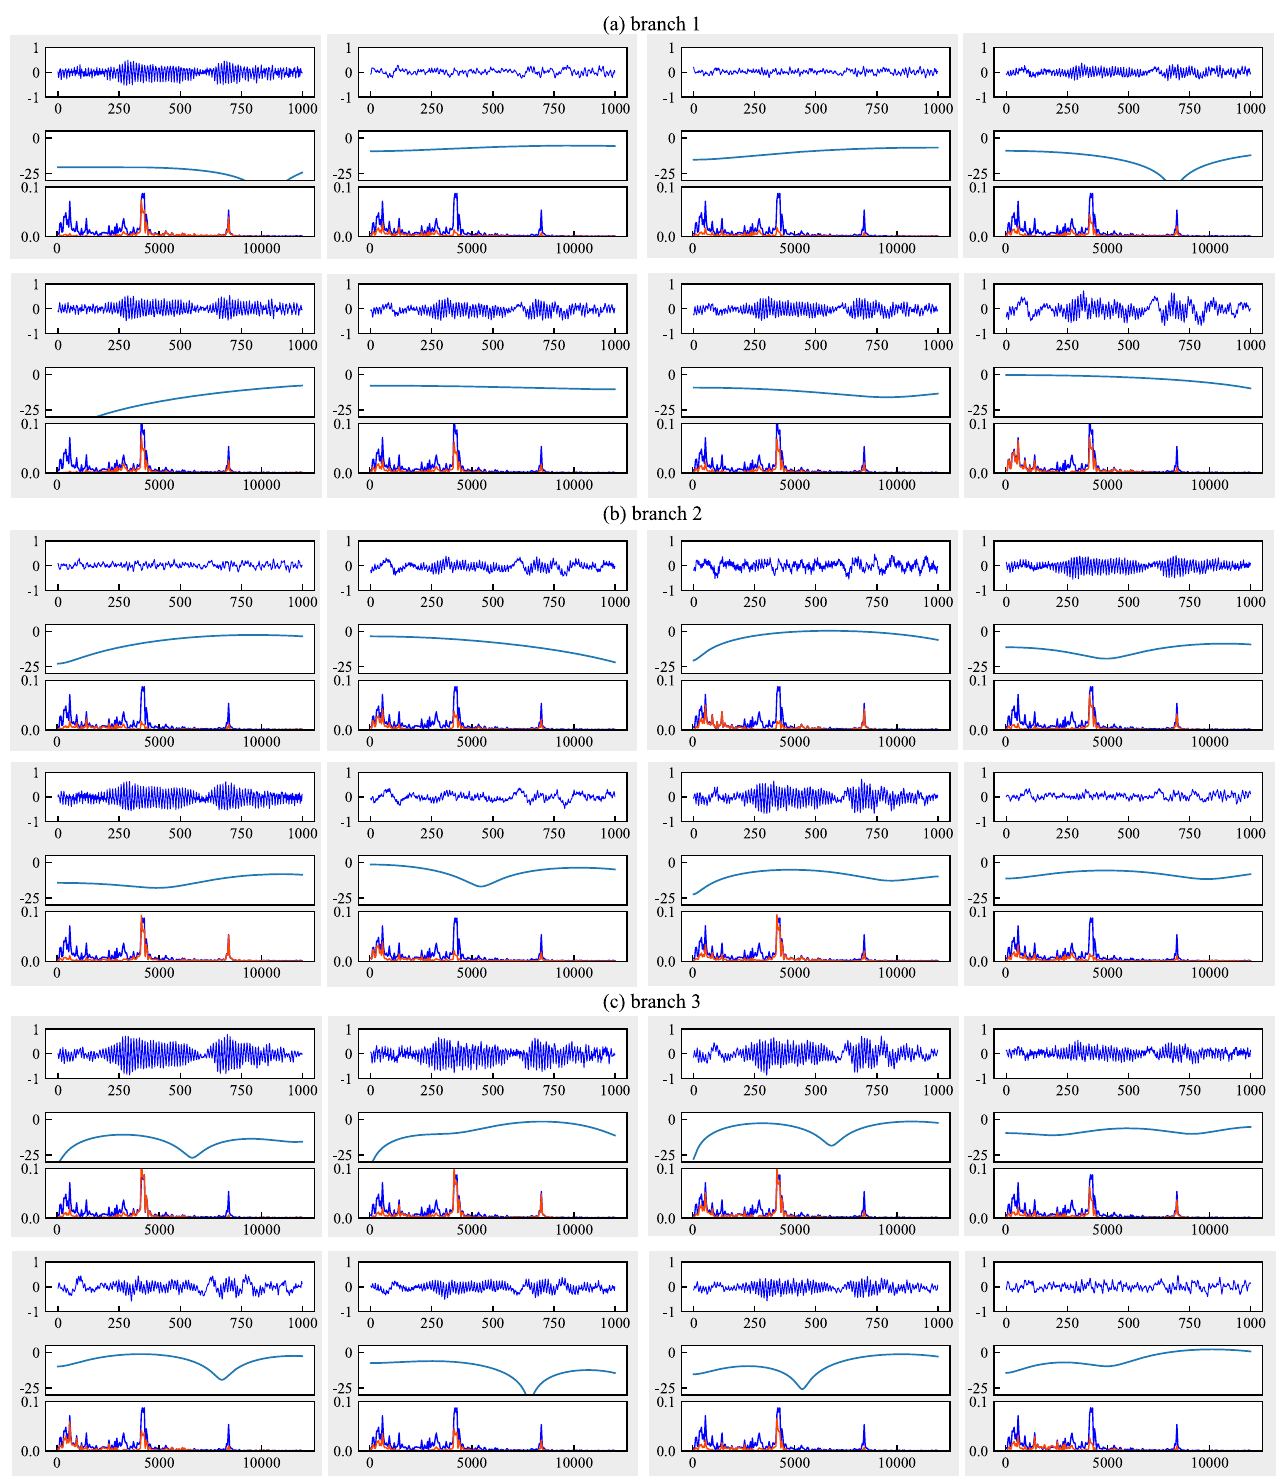
Figure 14. Amplitude-frequency characteristic curves of each filter in the first layer of FFCNN-A from task B 5 → B 1. ( a – c ) represent the branches 1, 2, 3 with a dilation rate = 1, 2, 3,